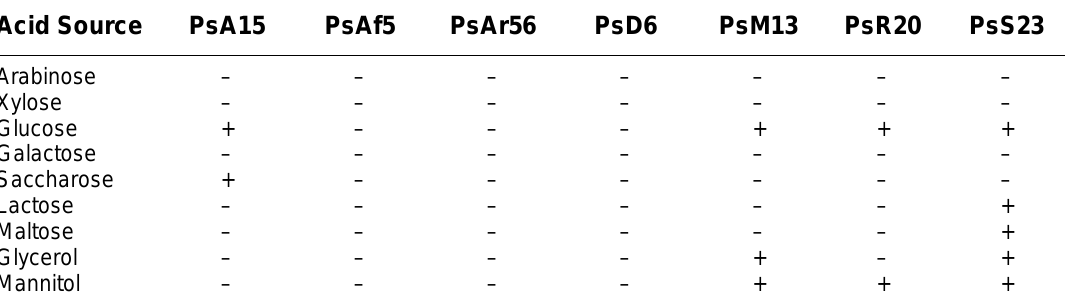
Carbohydrate Fermentation Pattern of Pseudomonas